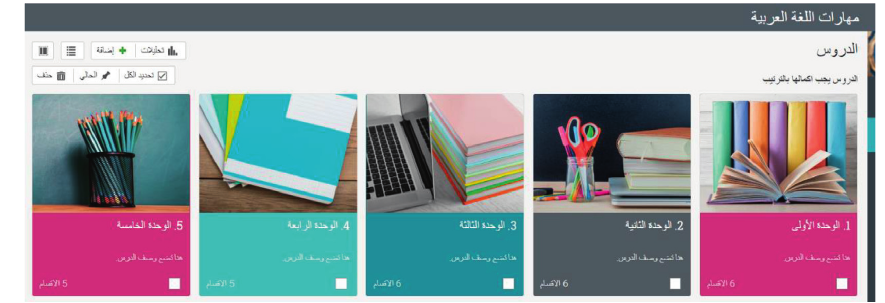
Figure 7: Interface of the blended syllabus in NEO Table 1: Content and activities in a sample unit.